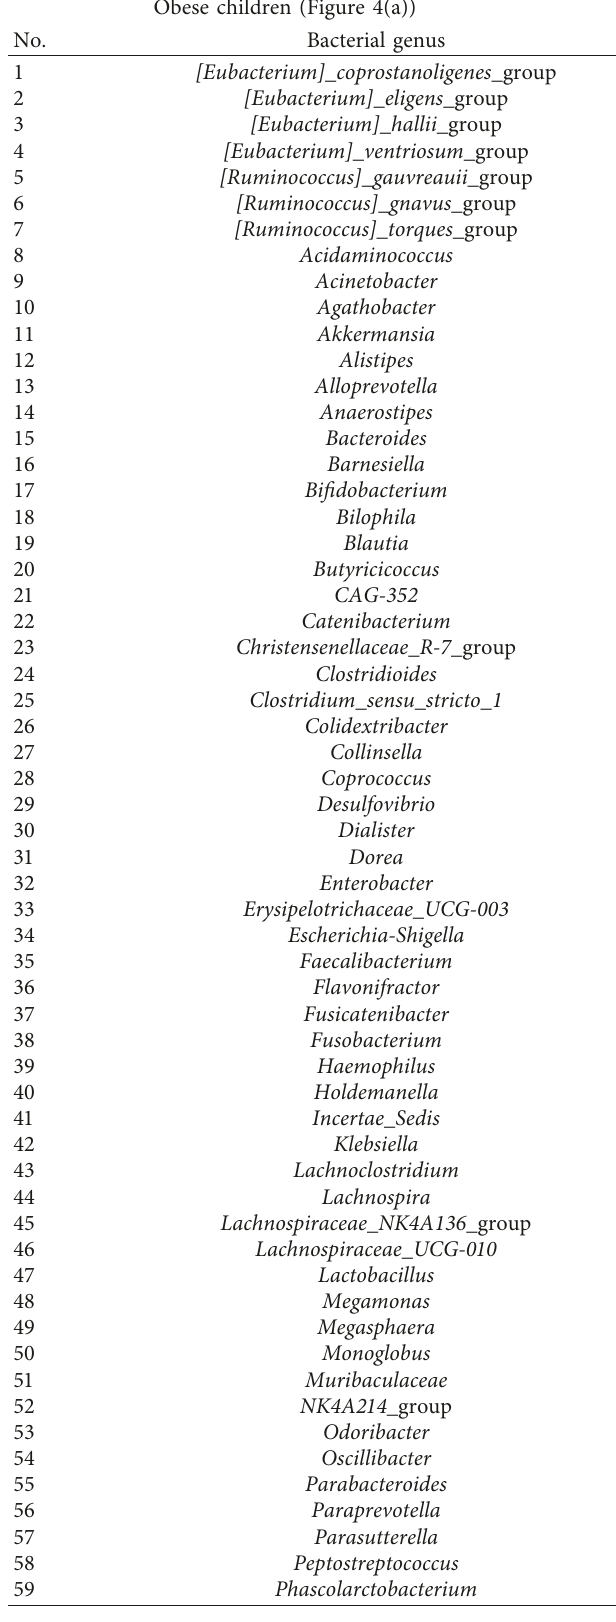
Table 2: List of bacterial genera for Figure 4. Obese children (Figure